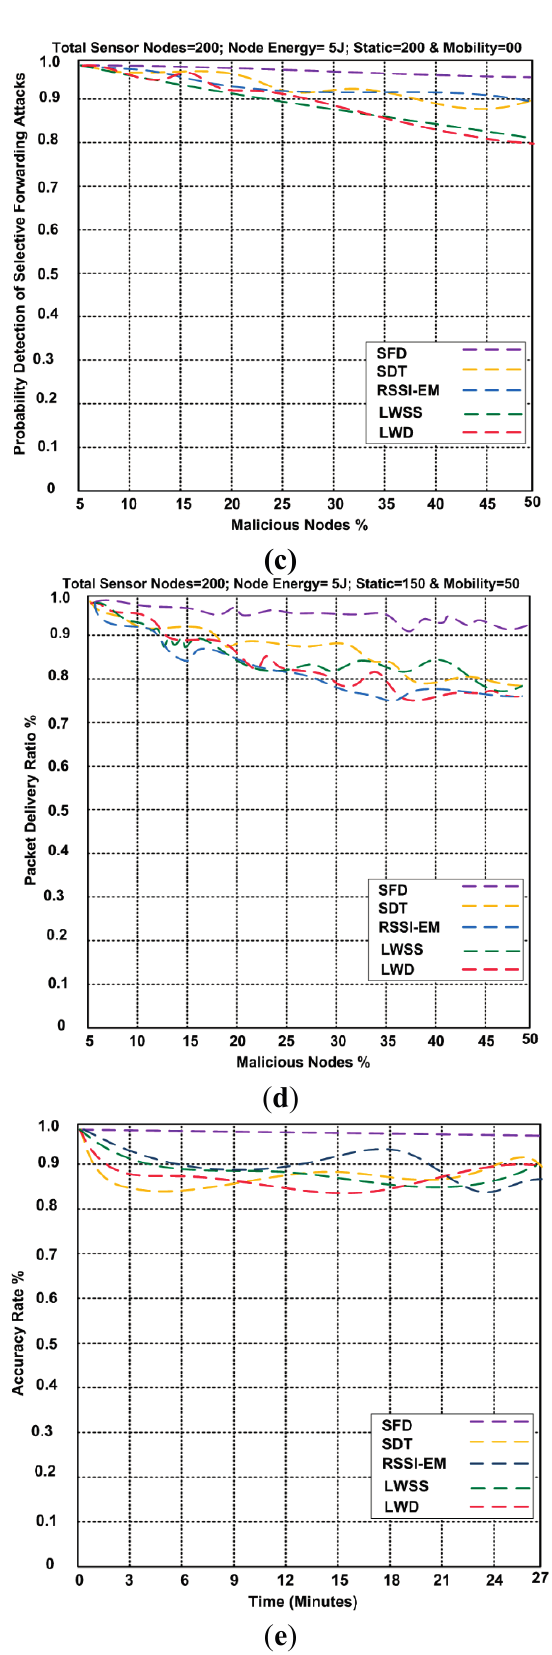
Figure 4. ( a ) Reliable detection rate of selective forwarding attack; ( b ) Energy consumptions; ( c ) Probability detection of selective forwarding attack; ( d ) Packet delivery ratio; ( e ) Accuracy